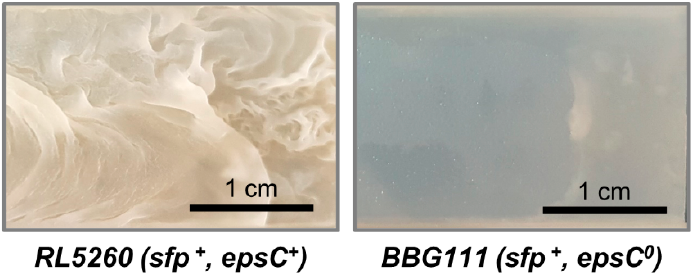
Figure 3. Demonstration of the biofilm development of a strain producing exopolysaccharides (RL5260, left side) or not (BBG111, right side). The images show sections of colonized silicone coupons incubated under identical growth conditions in a drip-flow reactor for 48 h.